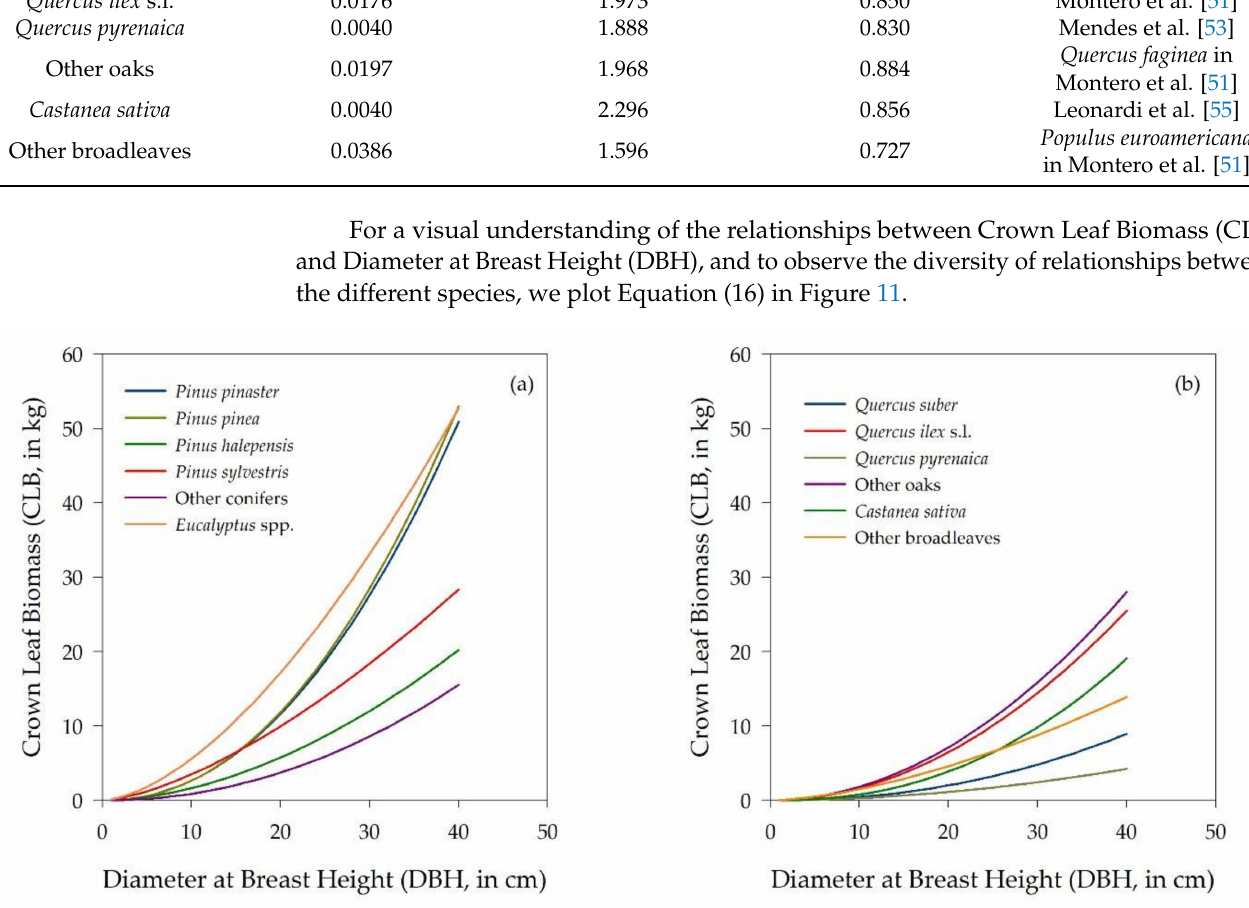
Figure 11. Crown Leaf Biomass (CLB, in kg) as a function of diameter at breast height (DBH): conifers and eucalypts ( a ), and oaks and other broadleaves ( b